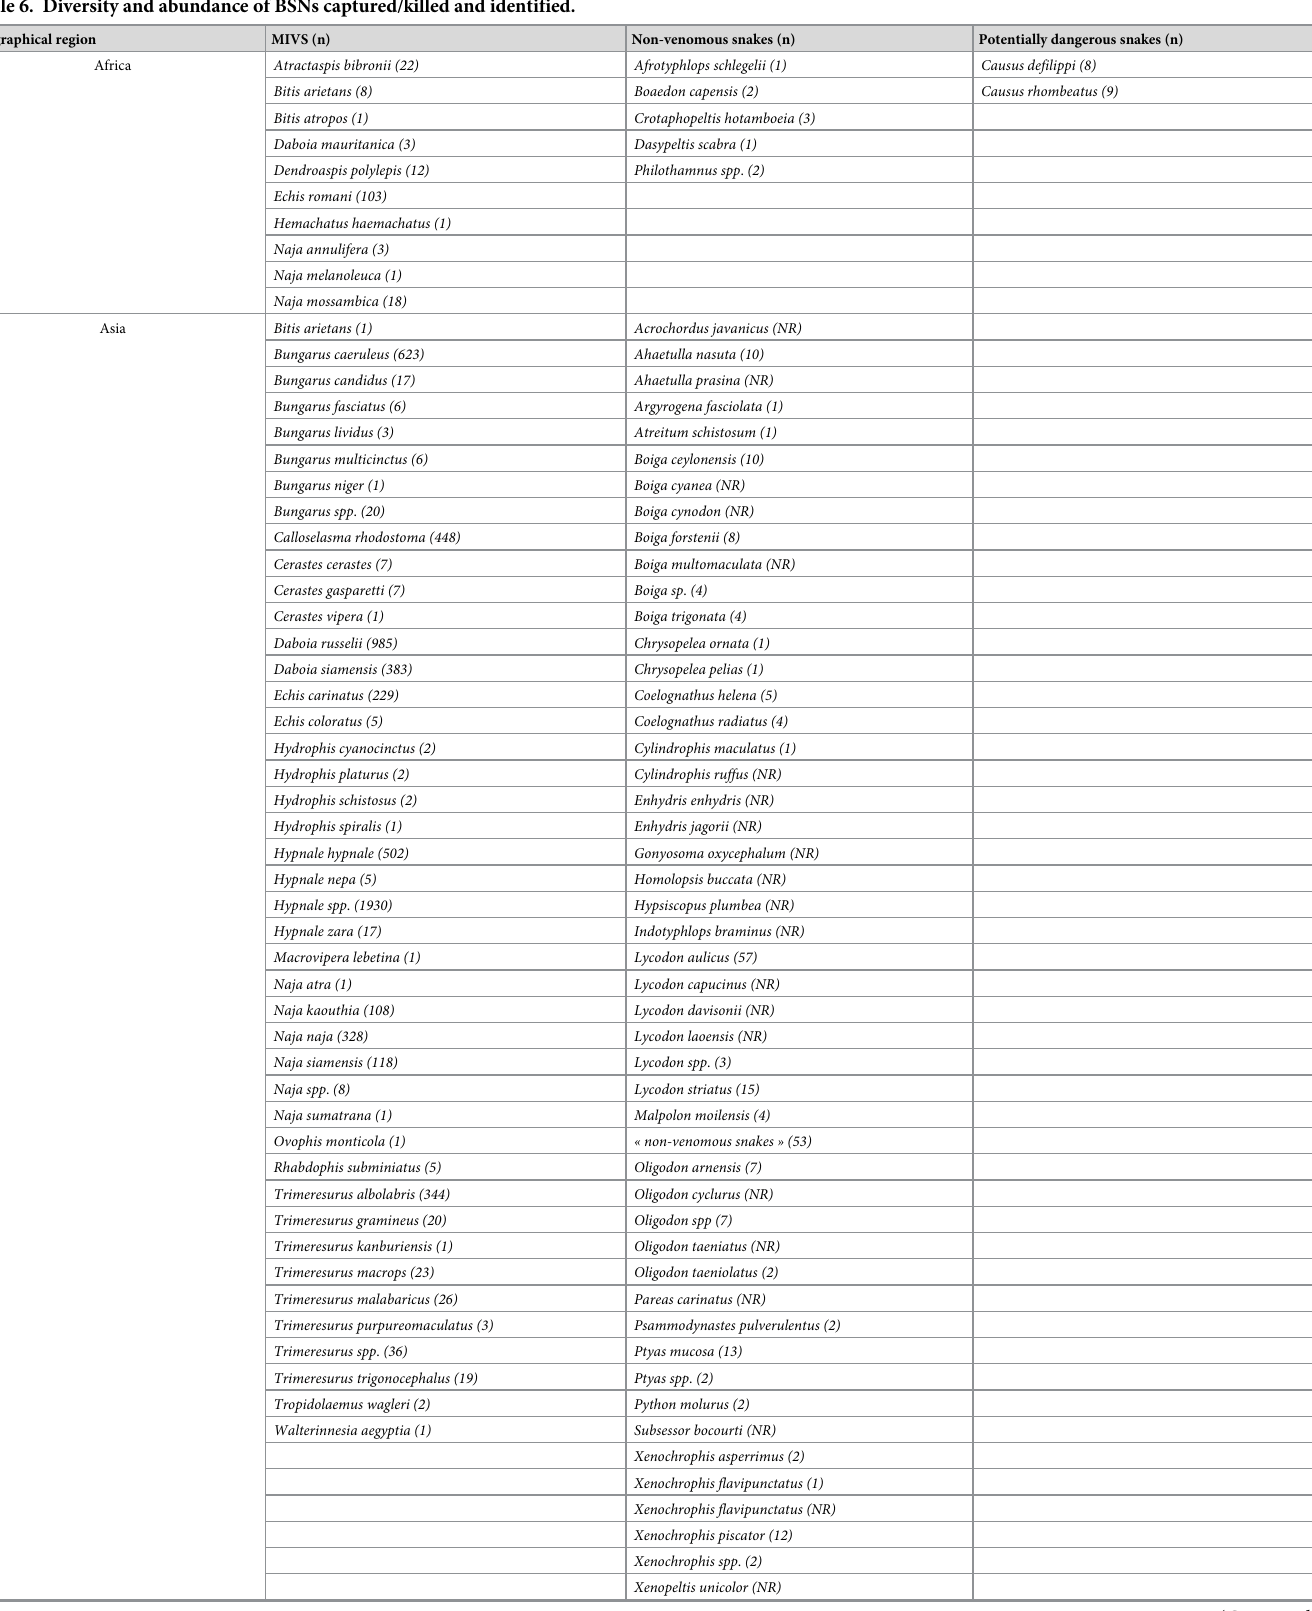
Table 6. Diversity and abundance of BSNs captured/killed and identified.